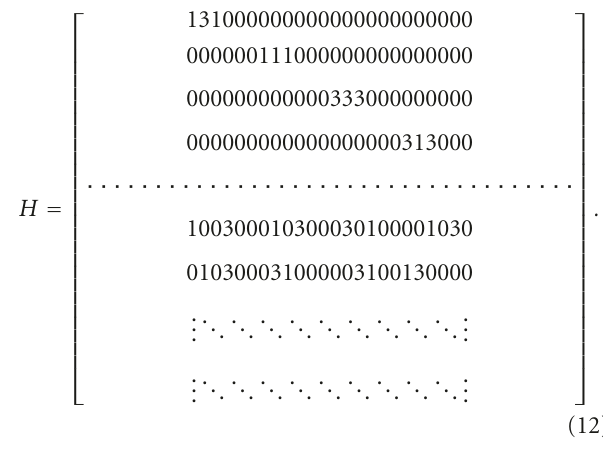
Figure 1. Local check nodes (shaded checks) and their edges (solid lines) are distinguished from the global check nodes and their edges (dash-dotted